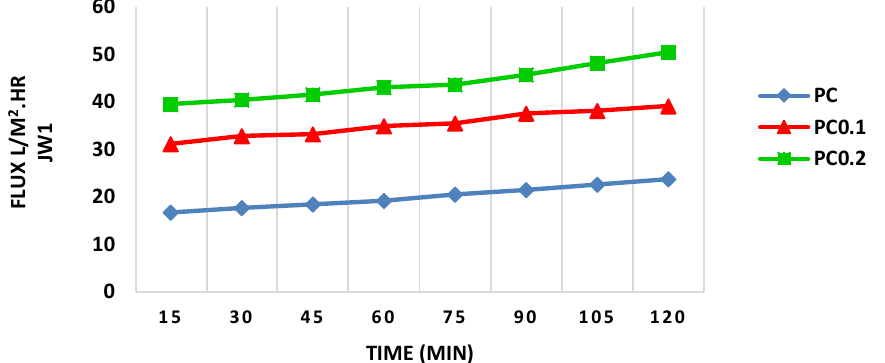
Figure 7: Pure Water Flux of PSF membranes without and with different TiO 2